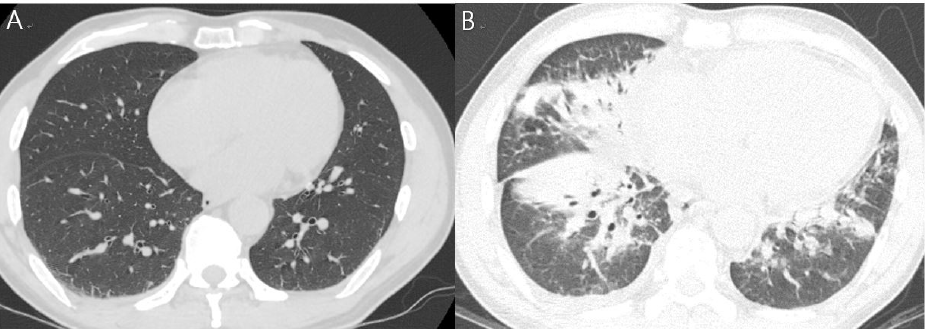
Figure 1. Chest computed tomography (CT). ( A ) Chest CT on admission demonstrating probably dependent atelectasis of the basal aspect of the right lower lobe and ( B ) on day 6 after admission indicating new-onset extensive consolidation and ground-glass opacity of the right middle lobe, lingular segment, and both lower lobes with increased right pleural effusion. Table 2. Serum and urine metal concentrations (sampled on day 5 of